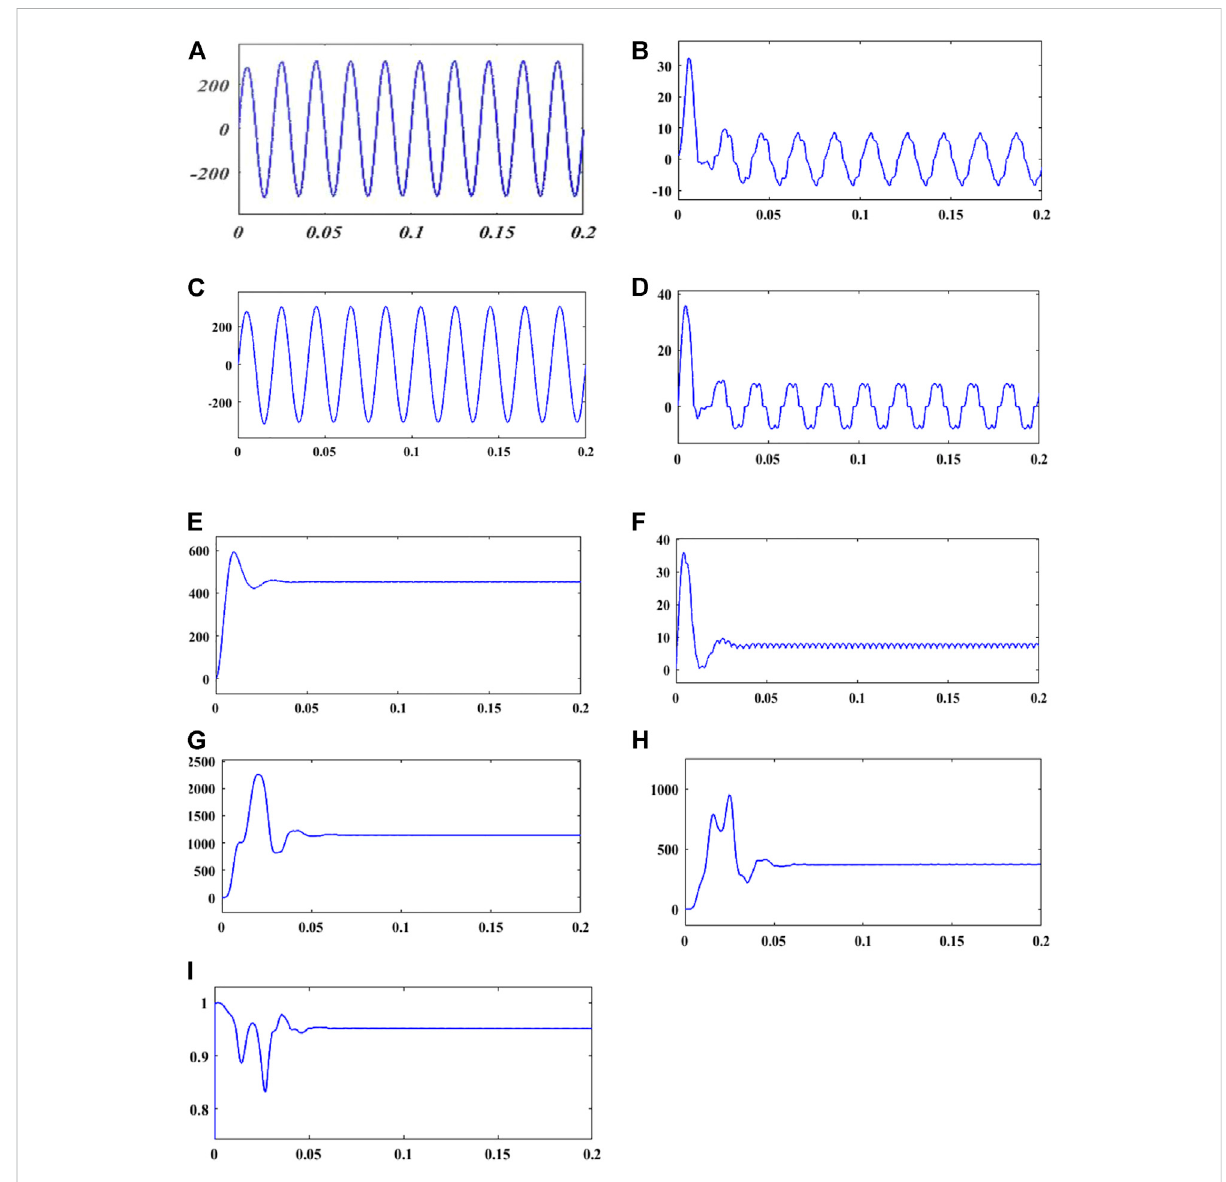
FIGURE 8 Voltage, current, and power waveform for with a fi fth-order harmonic fi lter. (A) Input voltage. (B) Input current. (C) Voltage at PCC. (D) Load current. (E) Voltage after recti fi er. (F) Current after recti fi er. (G) Real power. (H) Reactive power. (I) Power